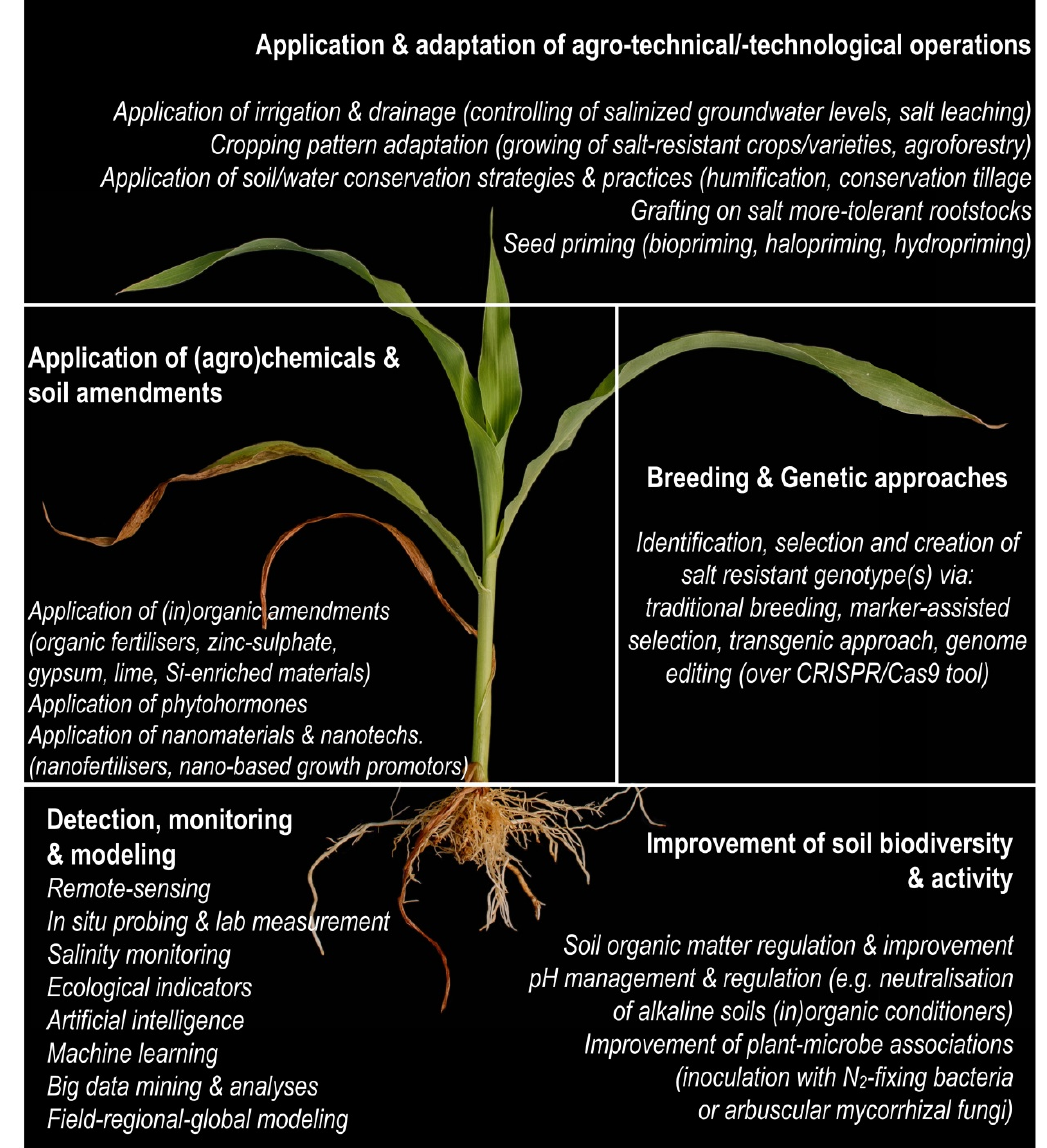
Figure 2. Solutions for salinization management and mitigating salt stress in plants.